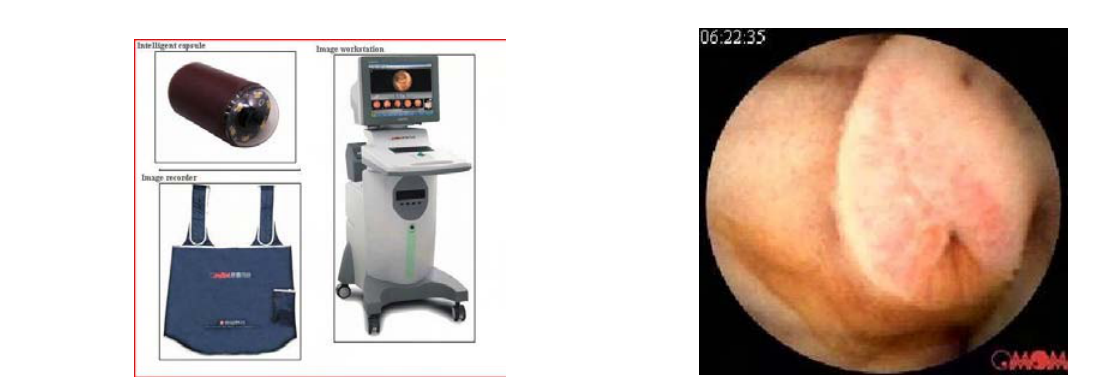
Figure 5: Diverticulitis at